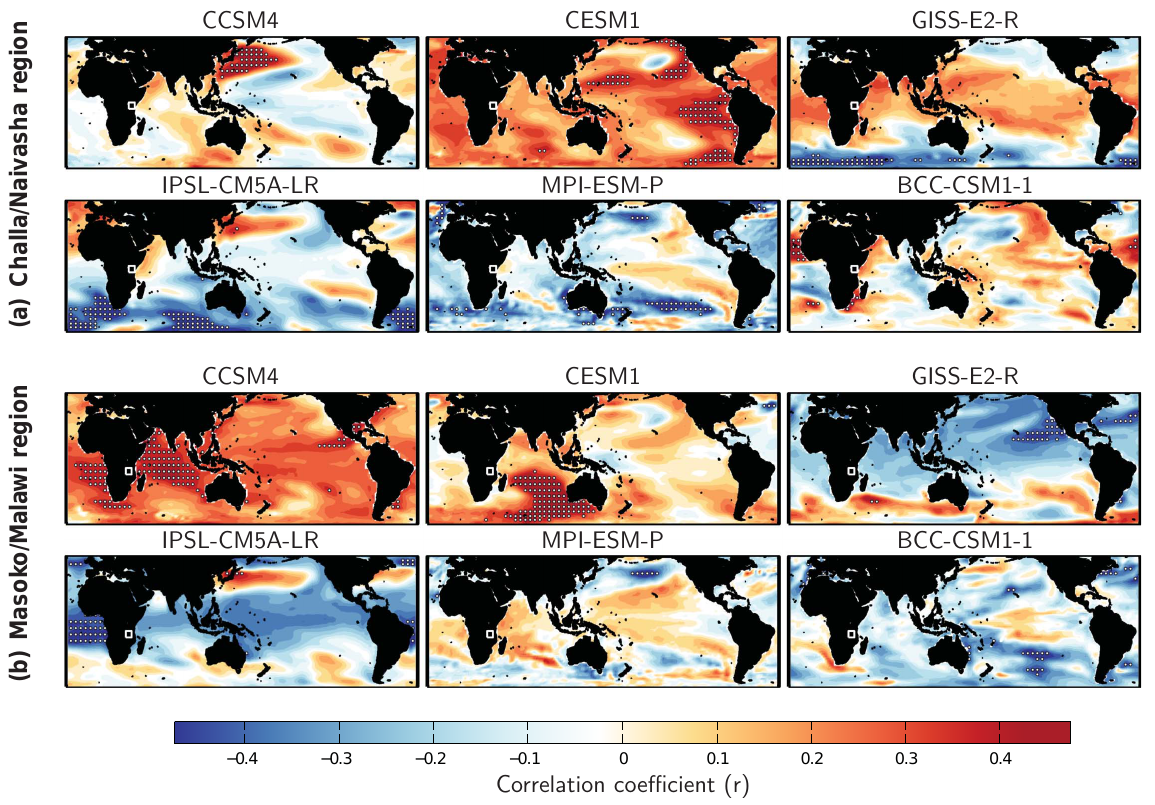
Figure 12. Pearson correlation coefficients between global SSTs and mean annual rainfall over the Challa–Naivasha (a) and Masoko– Malawi (b) regions in climate models for the pre-industrial period 850–1850 AD. Rainfall and SSTs are mean annual values smoothed using a loess filter with a window of 100 years. In areas overprinted by white circles the null hypothesis of no correlation can be rejected at the 5%